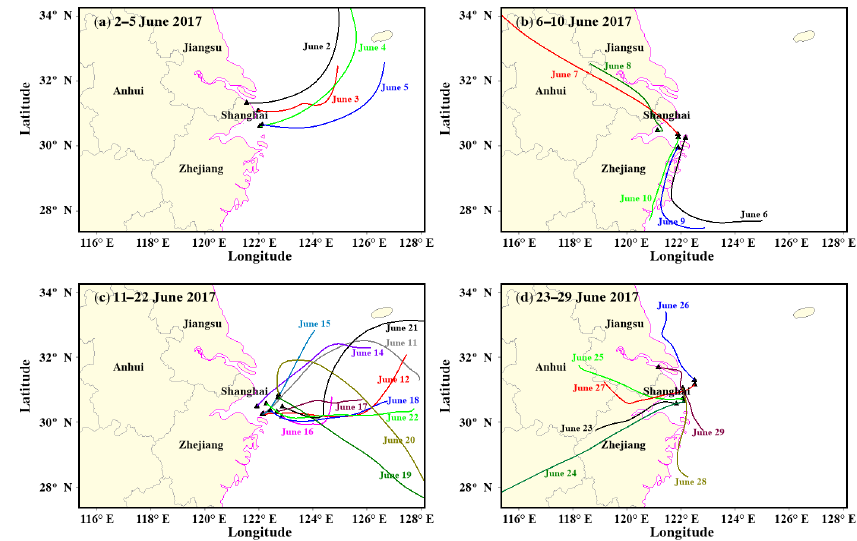
Figure 5. Daily 24h backward trajectories of air masses at 300m in altitude for (a) 2 to 5 June, (b) 6 to 10 June, (c) 11 to 22 June, and (d) 23 to 29 June 2017.